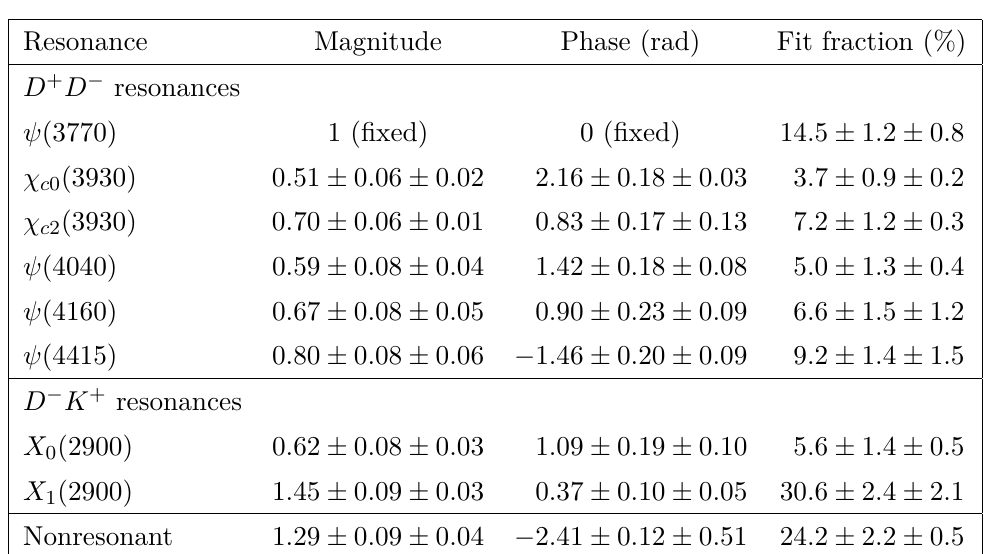
Figure 3 . The distribution over the invariant mass of D 0 ¯ D 0 in the decay B + → D 0 ¯ D 0 K + in the Babar [14] data. The dots show the data, the histograms show the resulting description by the model and individual contributions.